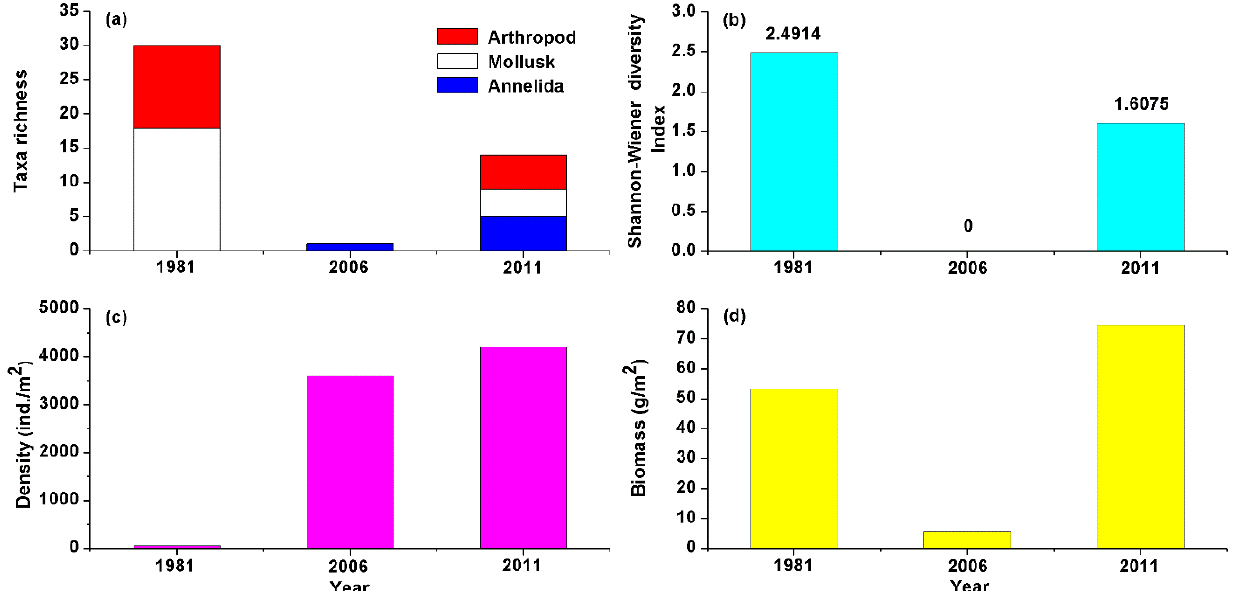
Figure 3. Changes in the composition of macroinvertebrate communities in the Guanlan River during the 30-year period from 1981 to 2011. ( a ) Taxa richness; ( b ) Shannon-Wiener diversity index; ( c ) Density; ( d ) Wet weight. The 1981 and 2006 data were obtained from the literature [17,18]. The 2011 data were collected from the